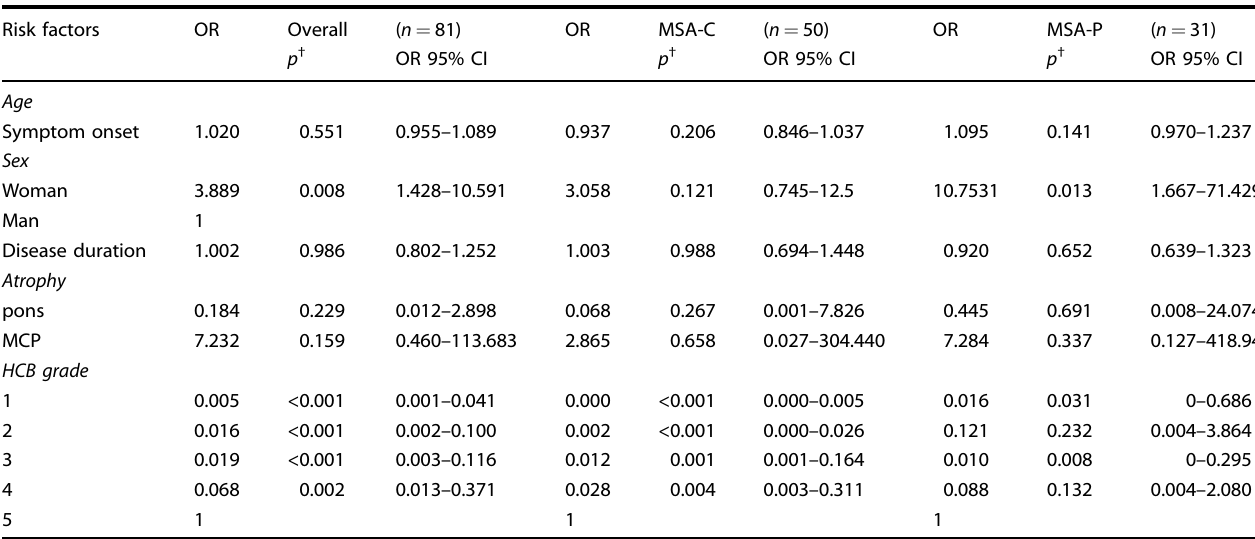
Fig. 2 Relationship between HCBs and the severity of ataxia in MSA patients. The Scatter plot showed the correlations between scores of each item of SARA and HCBs grade. Each dot represented on case. The red dot represented cases in MSA-C group and the green dot represented cases in MSA-P group. Table 5. Factors associated with disabilities in MSA